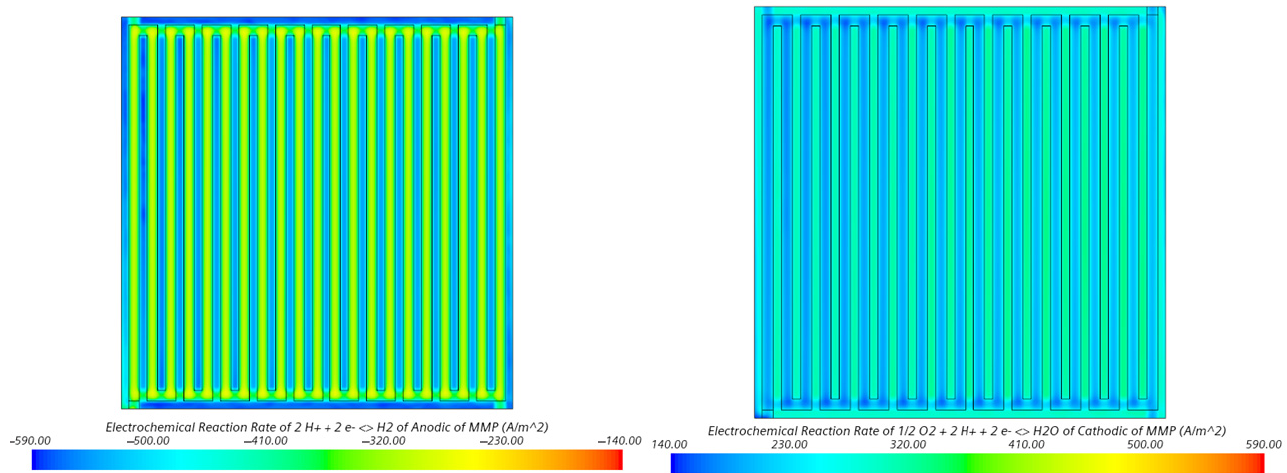
Figure 7. Section views of electrochemical reaction flux at anode ( left ) and cathode ( right ) for the 0.7 V case.